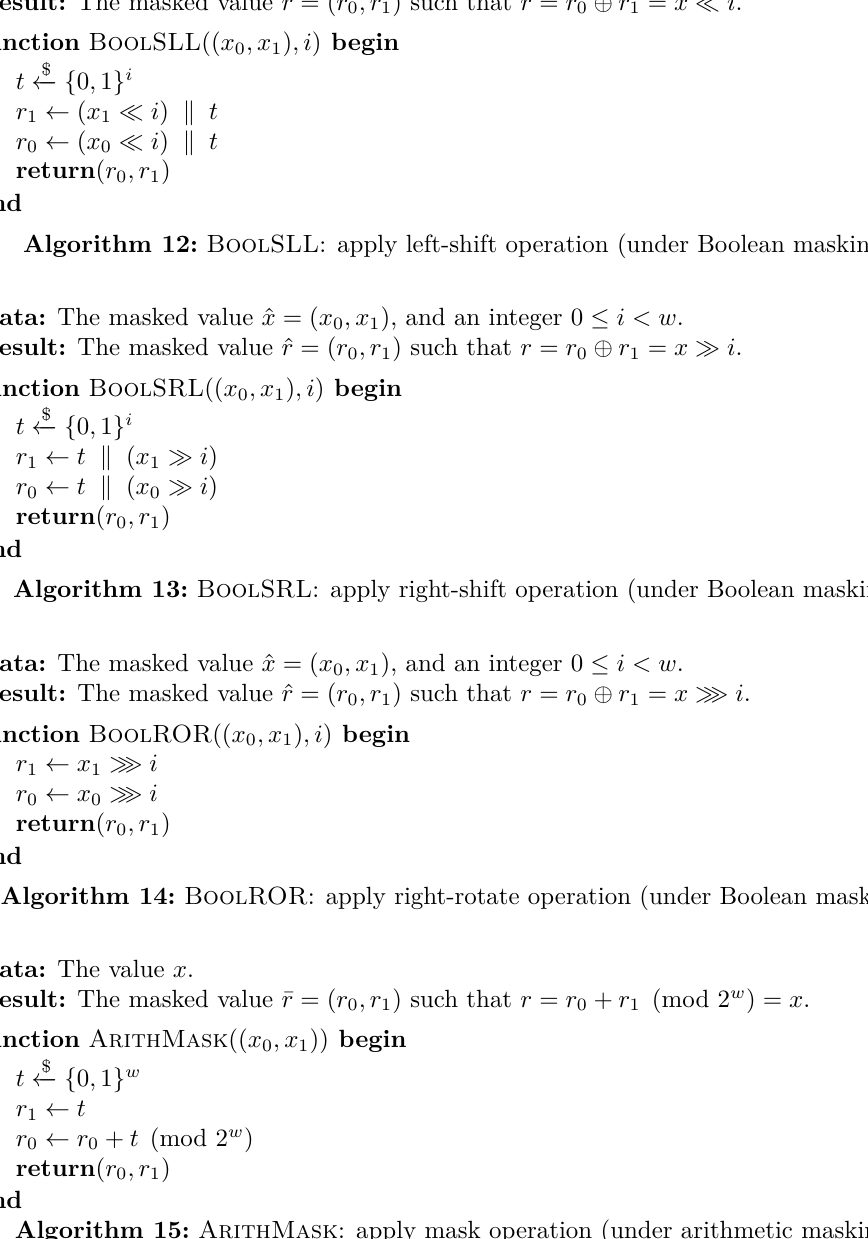
Algorithm 15: ArithMask : apply mask operation (under arithmetic masking).